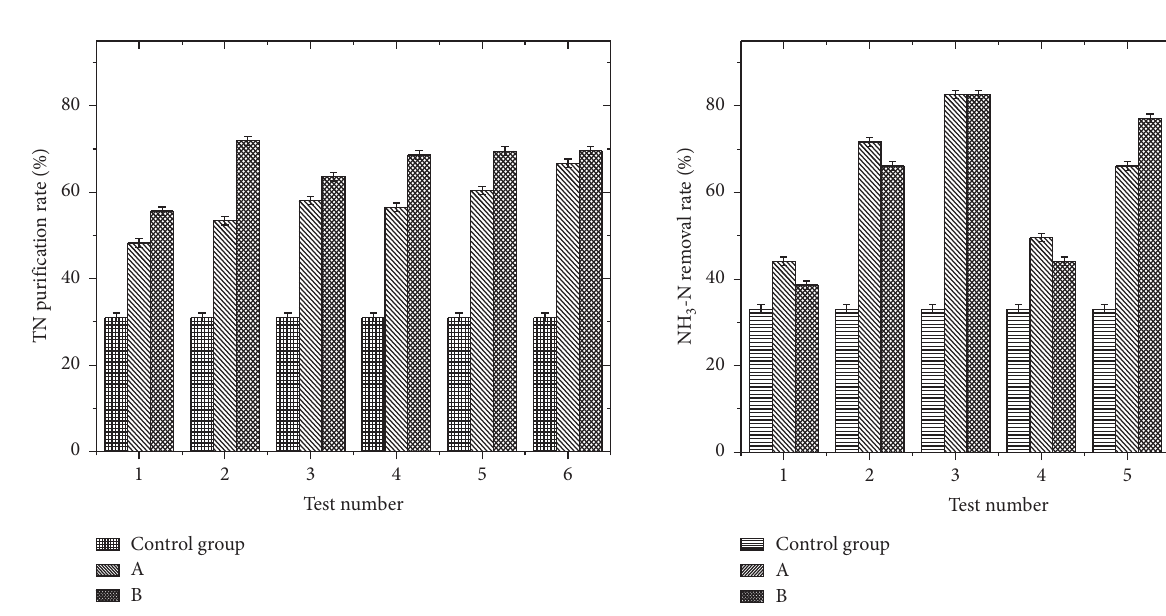
Figure 9: NH 3 -N purification effect of permeable concrete. Note: A-1 ∼ A-6: permeable concrete specimens with unmodified diato- mite and zeolite powder in different dosages; B-1 ∼ B-6: permeable concrete specimen with modified diatomite and zeolite powder in different